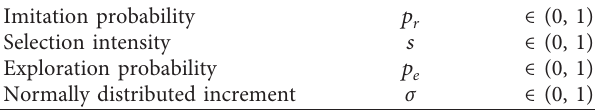
Table 2: Evolutionary part (four parameters).